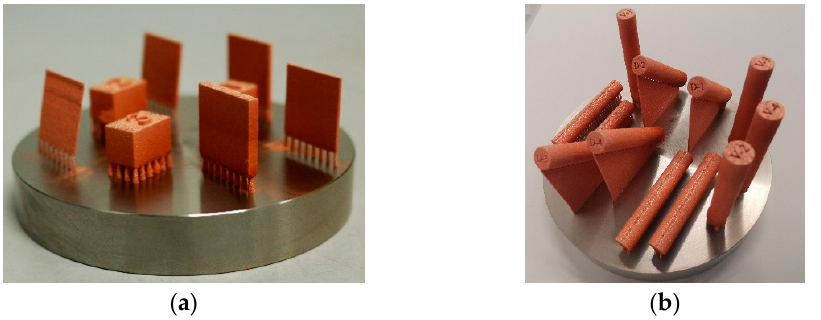
Figure 1. Steel build plate 100 mm in diameter with ( a ) density cubes 10 × 15 × 10 mm³ and vertical walls 20 × 20 mm² of different thicknesses and ( b ) cylinders with 8 mm diameter × 43 mm height for tensile samples in three building directions.